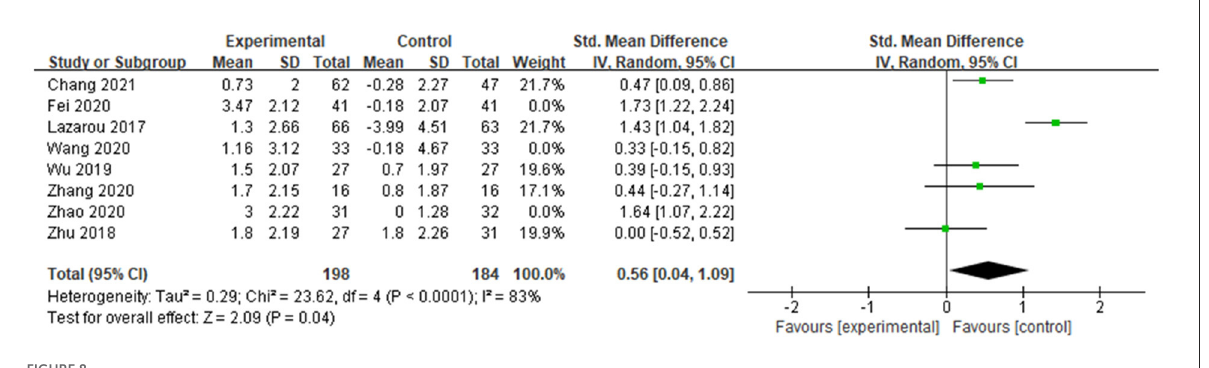
FIGURE8 Result of studies with strong quality